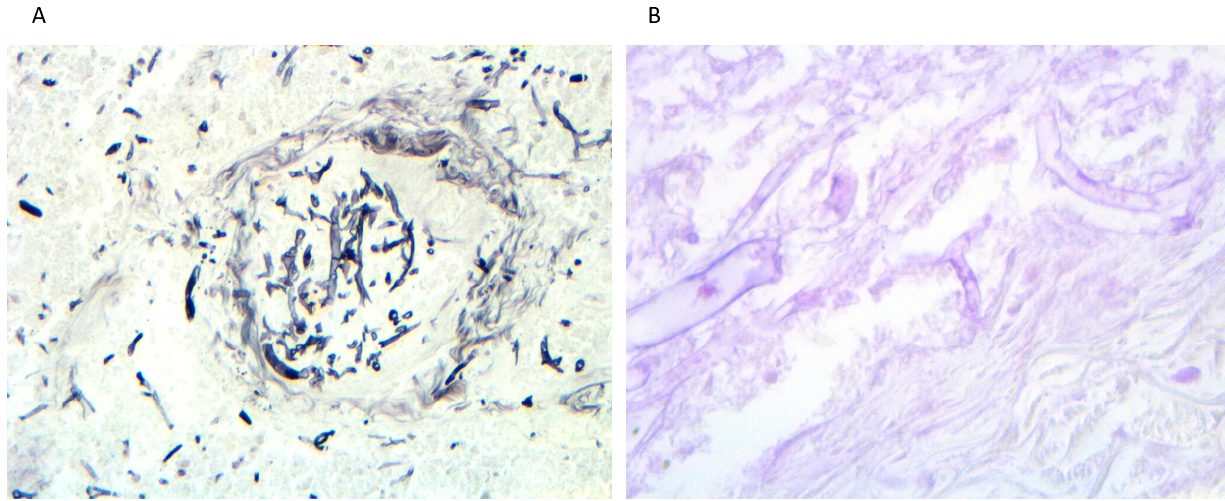
Figure 1. Lung tissue sections and histological examination showing the presence of septate hyphae, some causing angioinvasion. (( A ) Grocott stain, magnification 200×) and (( B ) PAS staining, magnification 400×).